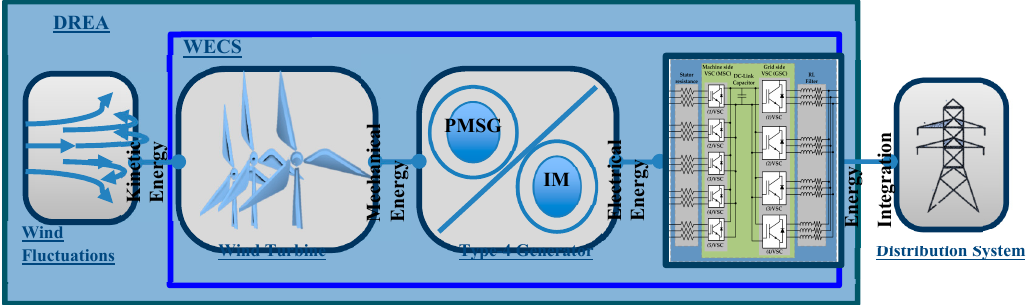
Figure 1. Wind to electrical energy transformation.